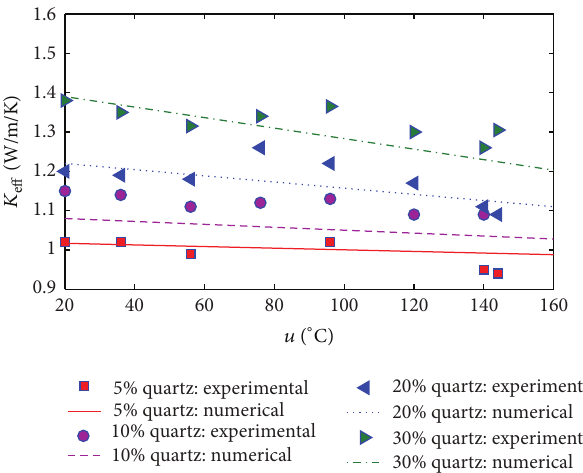
Figure 10: Contour of temperature in the heterogeneous media at different state of applied